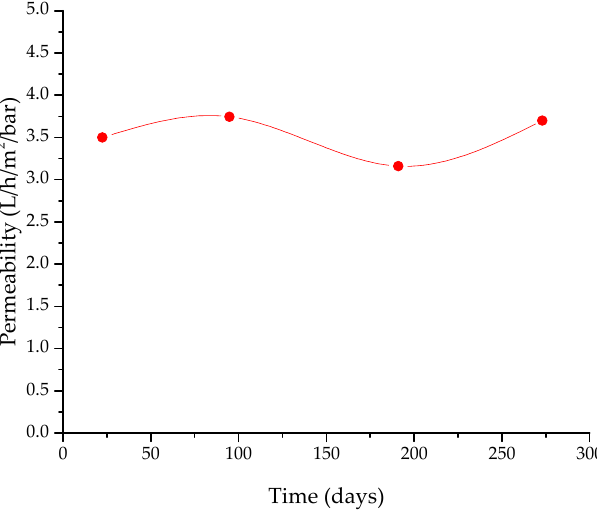
Figure 5. Water permeability of functionalized MPS36 over time.